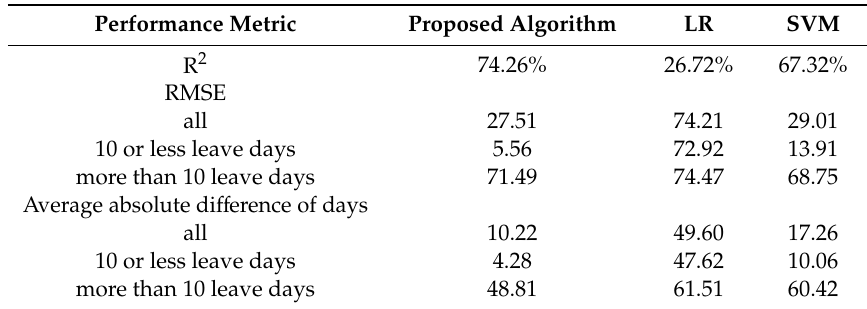
Figure 3. Histogram of the number of leave days of all those individuals that took part in the present research. Table 4. Comparison of the performance of the proposed algorithm with two benchmark methodologies, linear regression (LR) and support vector machines (SVM).